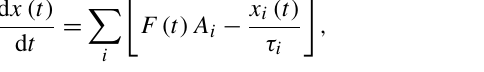
Figure 2. Response of the airborne fraction to an initial input of 100GtC without land CO 2 uptake and climate feedback. The line shows the case of reference amplitudes, and shading shows the range of the 5th–95th percentiles of the Prior ensemble, which is described in Sect.